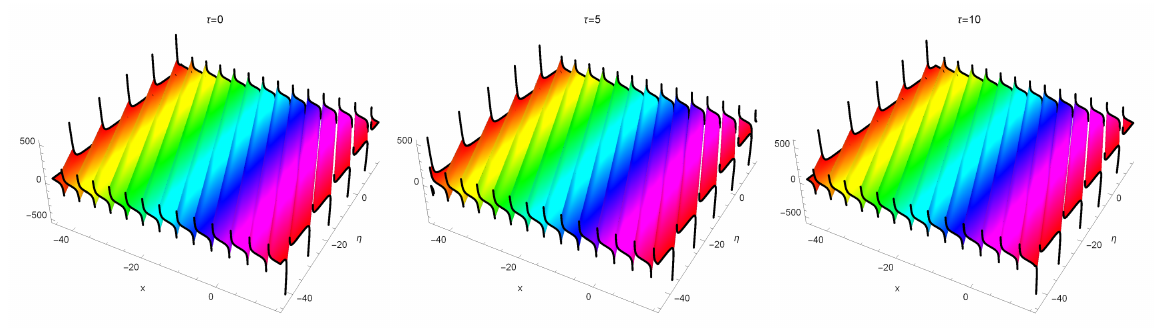
Fig. 2. The solution w 2 ( x , y , t ) for κ = 0.7, ω = 1, µ 1 = 0.5, µ 2 = 0.3, µ 3 = 0.2; α 0 = 1.